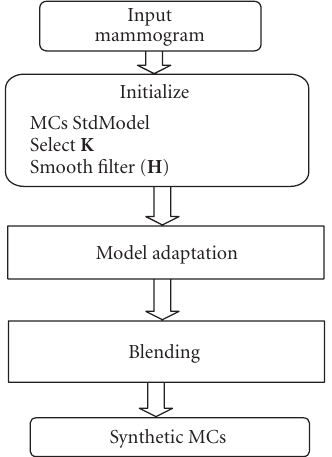
Figure 4: Construction of synthetic